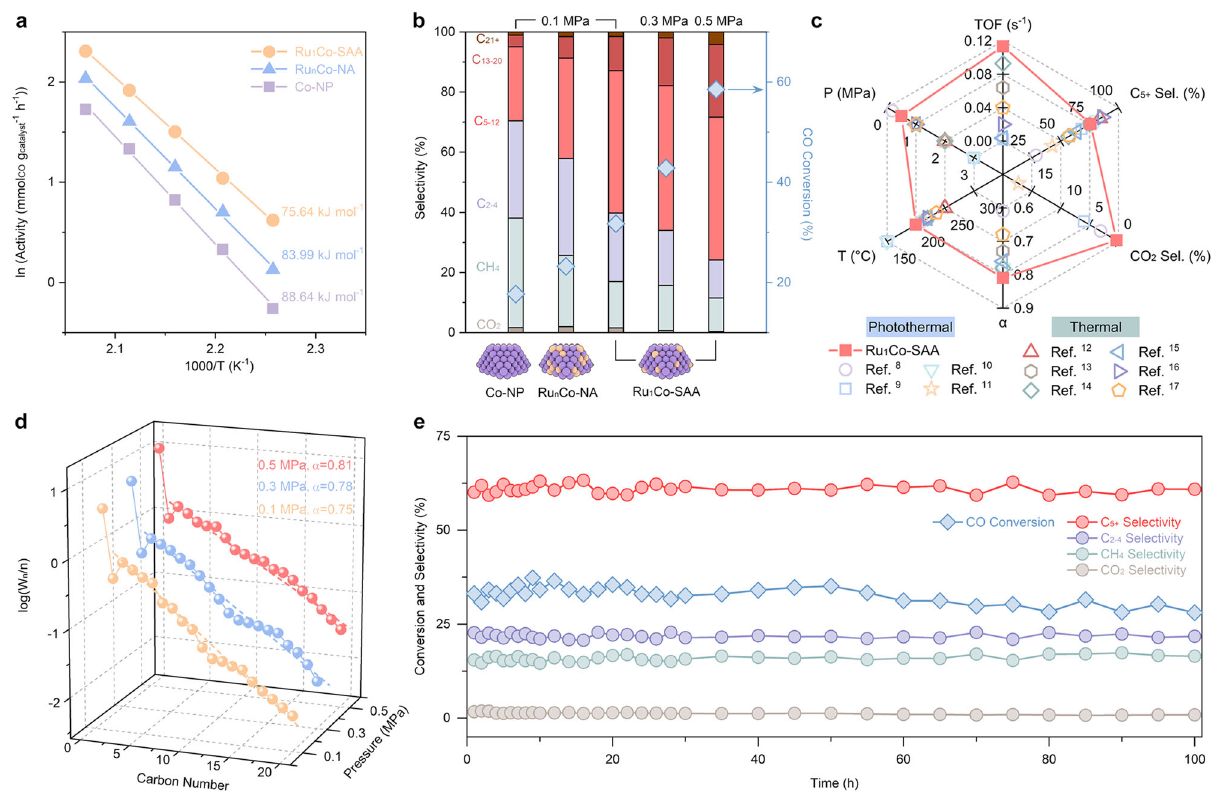
c ComparisonofFTSperformanceofRu 1 Co-SAAwithotherstate-of-the-artCo-based, Ru-based and RuCo-alloyed catalysts. P pressure, T temperature, α ASF chain growth probability, Sel selectivity, TOF turnover frequency. d The hydrocarbon product dis- tribution obtained over Ru 1 Co-SAA under UV-Vis irradiation. e Durability test on Ru 1 Co-SAA under 1.80Wcm − 2 UV-Vis